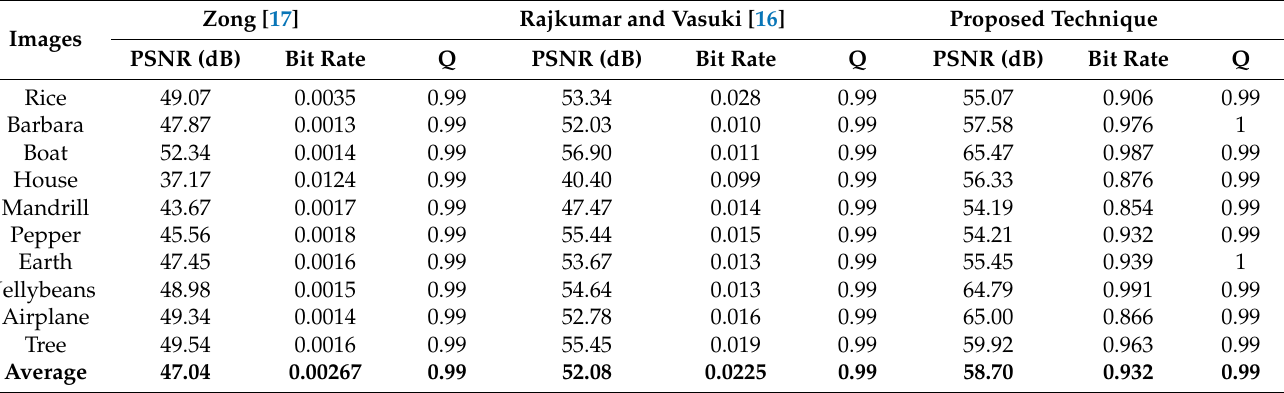
Table 7. Results for PSNR, bpp, and